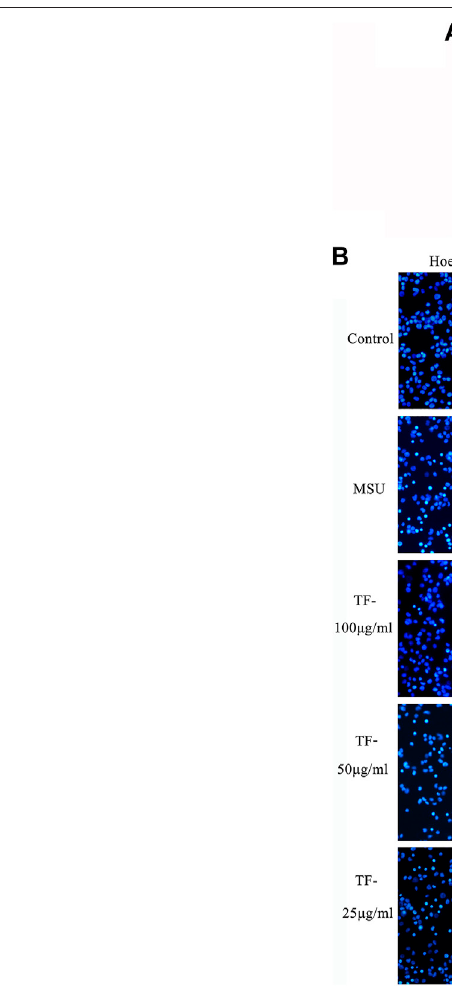
FIGURE 5 | Effects of TF and AM on membrane integrality in LPS/MSU-induced THP-1 cells (A) The rate of LDH release level. (B) . Hochest33342 and PI double staining images were captured by fl uorescence microscopy (200 × ). Red shows membrane-damaged cells. Blue shows nuclei. * p < 0.05 and ** p < 0.01, signi fi cantly different the normal control group; # p < 0.05 and ## p < 0.01, signi fi cantly different the LPS/MSU control group. TF, fl avonoid extract; AM, amento fl